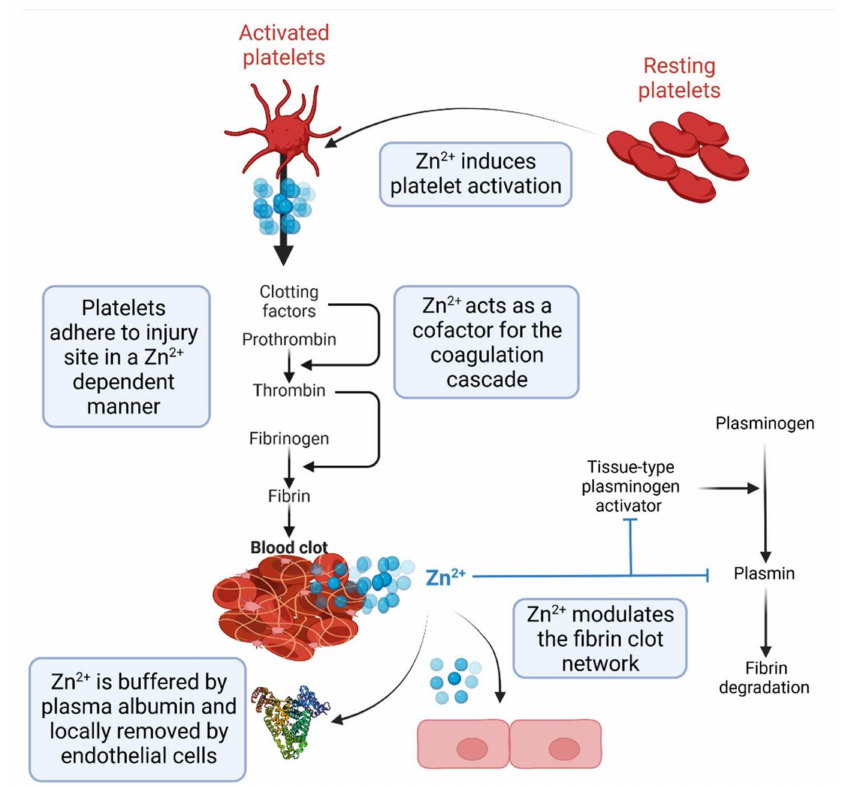
Figure 1. The role of Zn 2+ in thrombus formation. Zn 2+ acts as an essential cofactor for the activation of platelets, for the coagulation cascade culminating in the conversion of fibrinogen to fibrin and for the fibrinolytic processes that prevent vascular occlusion from thrombus breakage. Activated platelets release Zn 2+ ions, activating surrounding resting platelets and initiating morphological changes that cause platelets to adhere to the site of the vascular breach. Zn 2+ additionally serves as a cofactor in the initiation of both the intrinsic and extrinsic coagulation pathways that convert fibrinogen to fibrin. Finally, Zn 2+ modulates fibrinolysis, preventing fibrin overgrowth and, ultimately, vascular occlusion. The availability of Zn 2+ in plasma is controlled by HSA. Created using